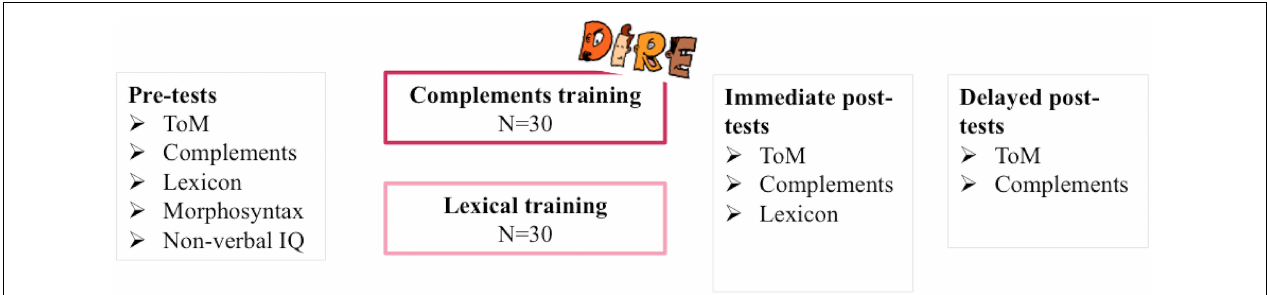
FIGURE 1 | Experimental